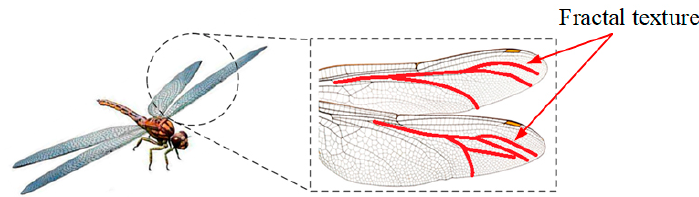
Figure 2. The fractal texture of the wings of dragonflies.